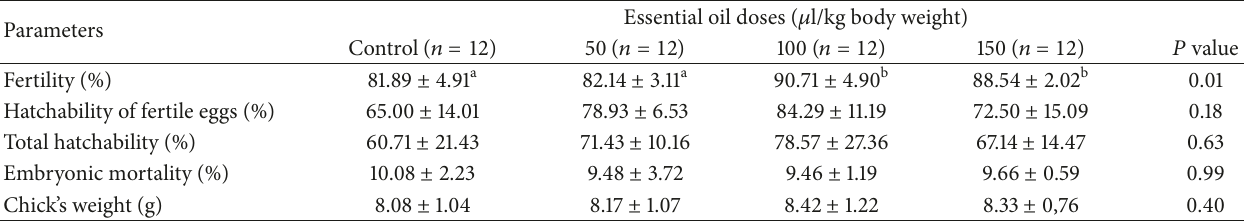
Table 6: Effects of graded levels of ginger essential oil on fertility rate and hatchability traits in Japanese